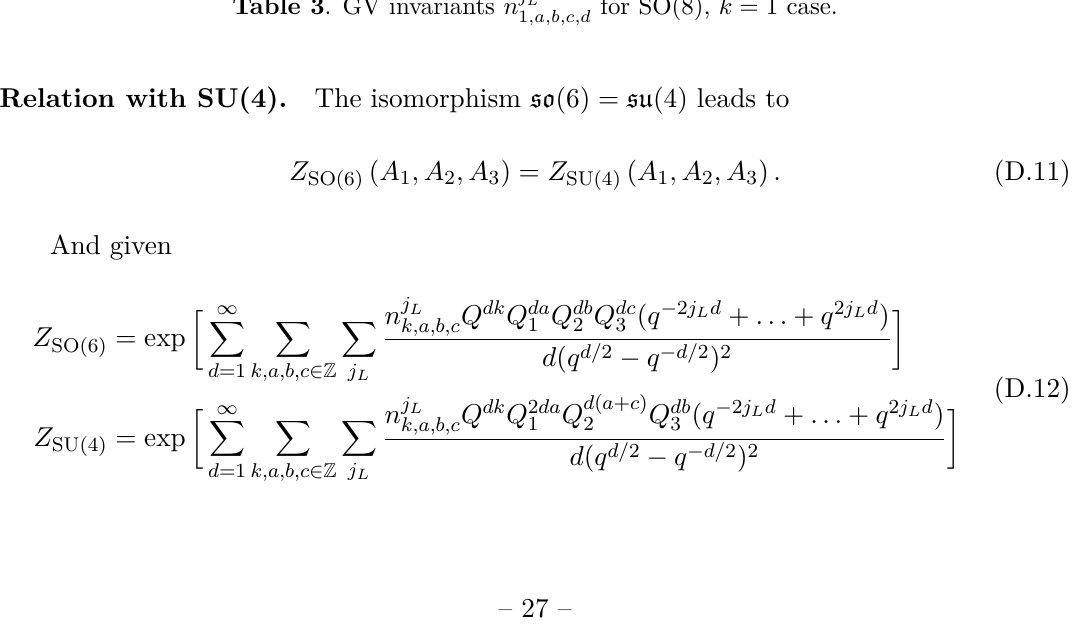
Table 3 . GV invariants n j L